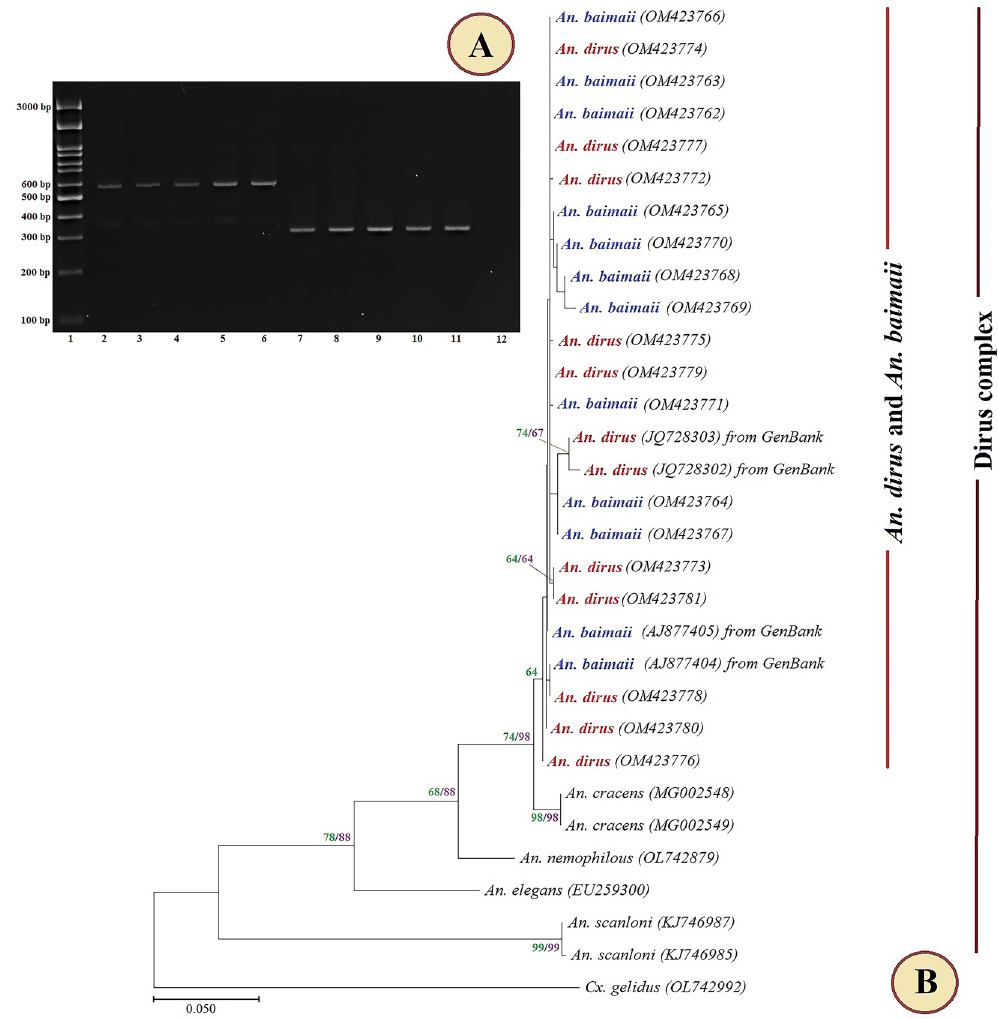
Figure 3. PCR product of the multiplex PCR assay based on the ITS2 region for species identification ( A ). Lane 1: 3000 bp molecular ladder; lanes 2–6: An. dirus (562 bp); lanes 7–11: An. baimaii (306 bp); lane 12: negative control. Maximum likelihood tree based on the COI sequences of An. dirus (red) and An. baimaii (blue) in this study, and reference Anopheles species sequences obtained from GenBank, with Culex gelidus as the outgroup taxon ( B ). Bootstrap values (1000 replicates) of maximum likelihood (green) and neighbor joining (purple) higher than 50% are shown at the nodes.